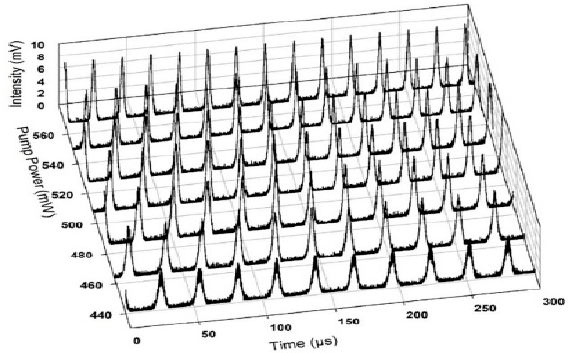
Figure 8. Evolution of the repetition rate of Q-switched laser.